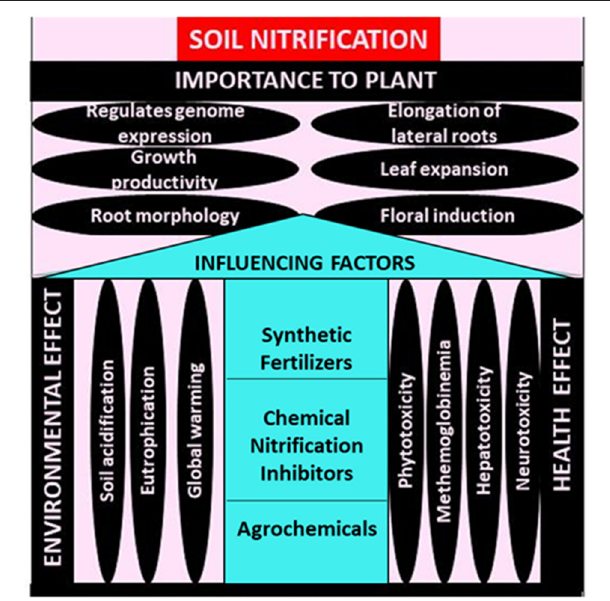
FIGURE 1 | Effect of influencing soil nitrification process